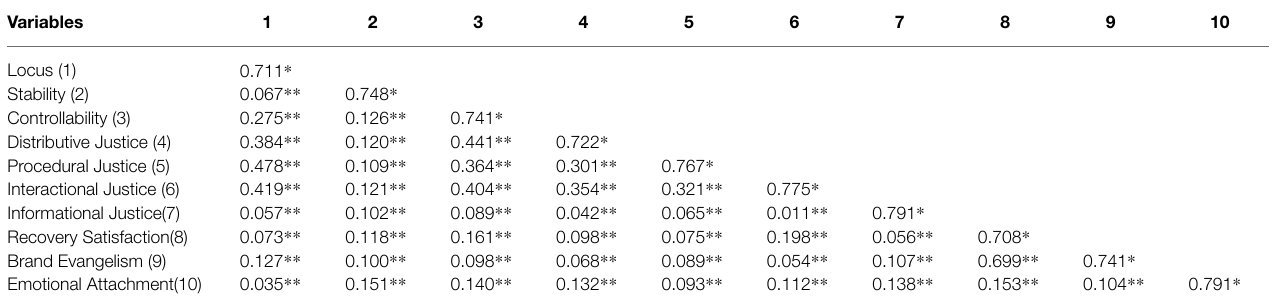
* Values on the diagonal are square root of the AVE; ** the off-diagonals are correlations.